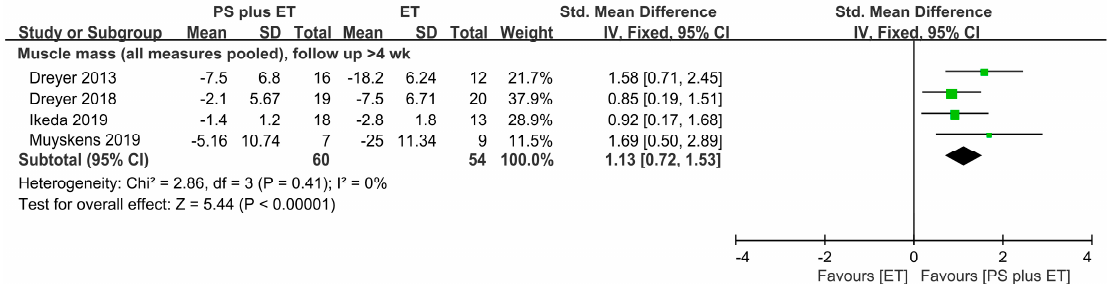
Figure 2. Forest plot summarizing the effects of postoperative protein supplementation (PS) plus exercise training (ET) on changes in muscle mass over medium-term follow-up. The square represents the point estimate of the intervention effect for each trial. The horizontal line links the lower and upper limits of the 95% CI for the given effect. The area of the squares indicates the relative weight of the trials in the meta-analysis. Trial results plotted on the right-hand side of the vertical axis indicate effects in favor of protein supplementation. The combined effects are plotted using black diamonds. 95% CI, 95% confidence interval; Std, standard; IV, inverse variance.